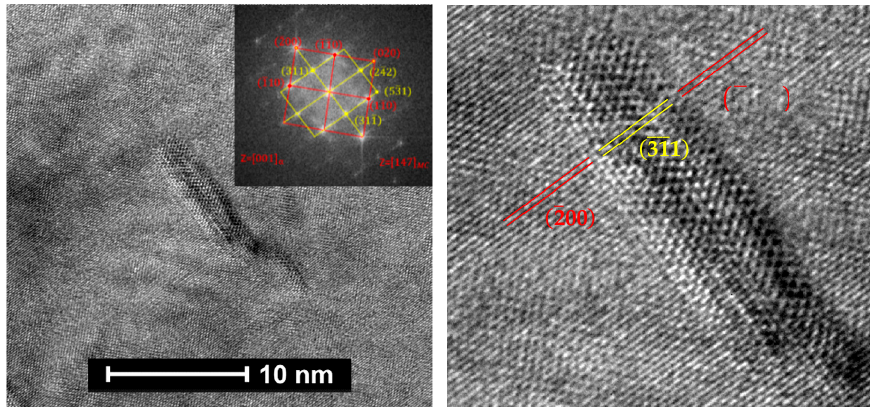
Figure 11. The corresponding SAED pattern of nano-sized short rod-shaped precipitates in 25Cr3Mo2NiWVNb steels.